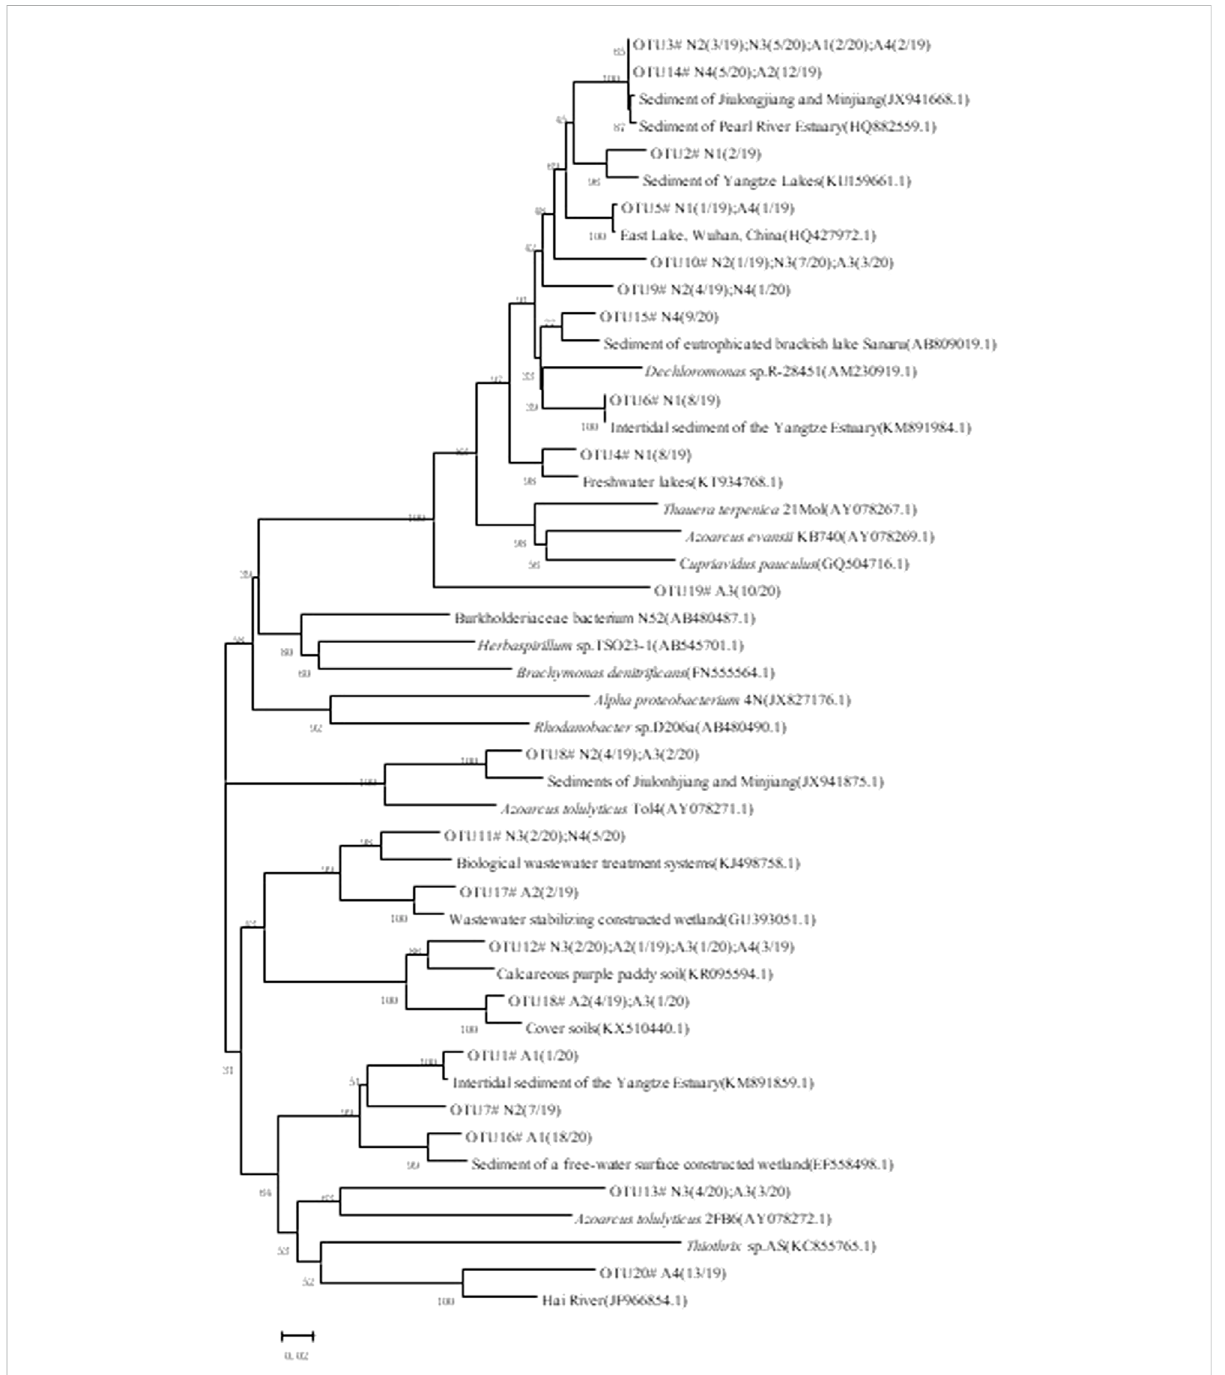
FIGURE 2 Denitrifying nirS genes in the denitri fi cation and anammox